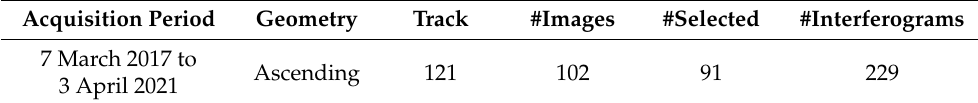
Table 3. Number of Sentinel-1A images and interferograms considered in ISBAS